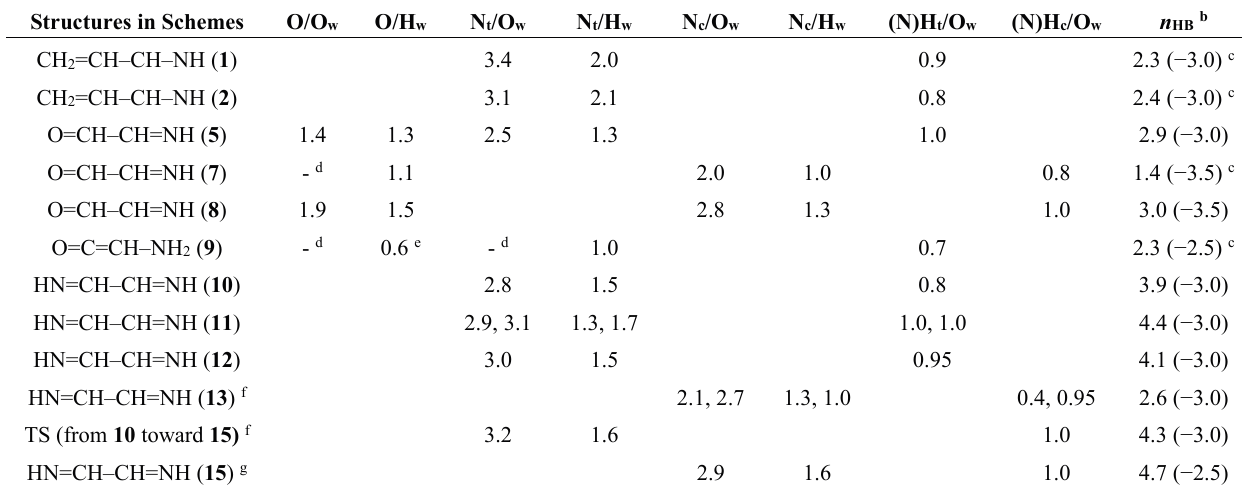
Table 4. Coordination numbers (CN) and number of hydrogen bonds ( n HB ) in aqueous solution a . Structures in Schemes O/O